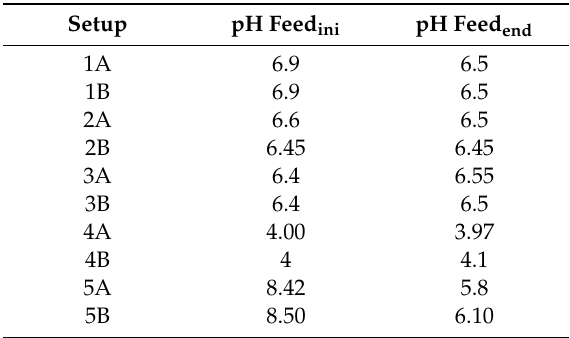
Table 2. Initial and final pH of the corresponding feed solutions. A and B correspond to the repetitions of the experimental